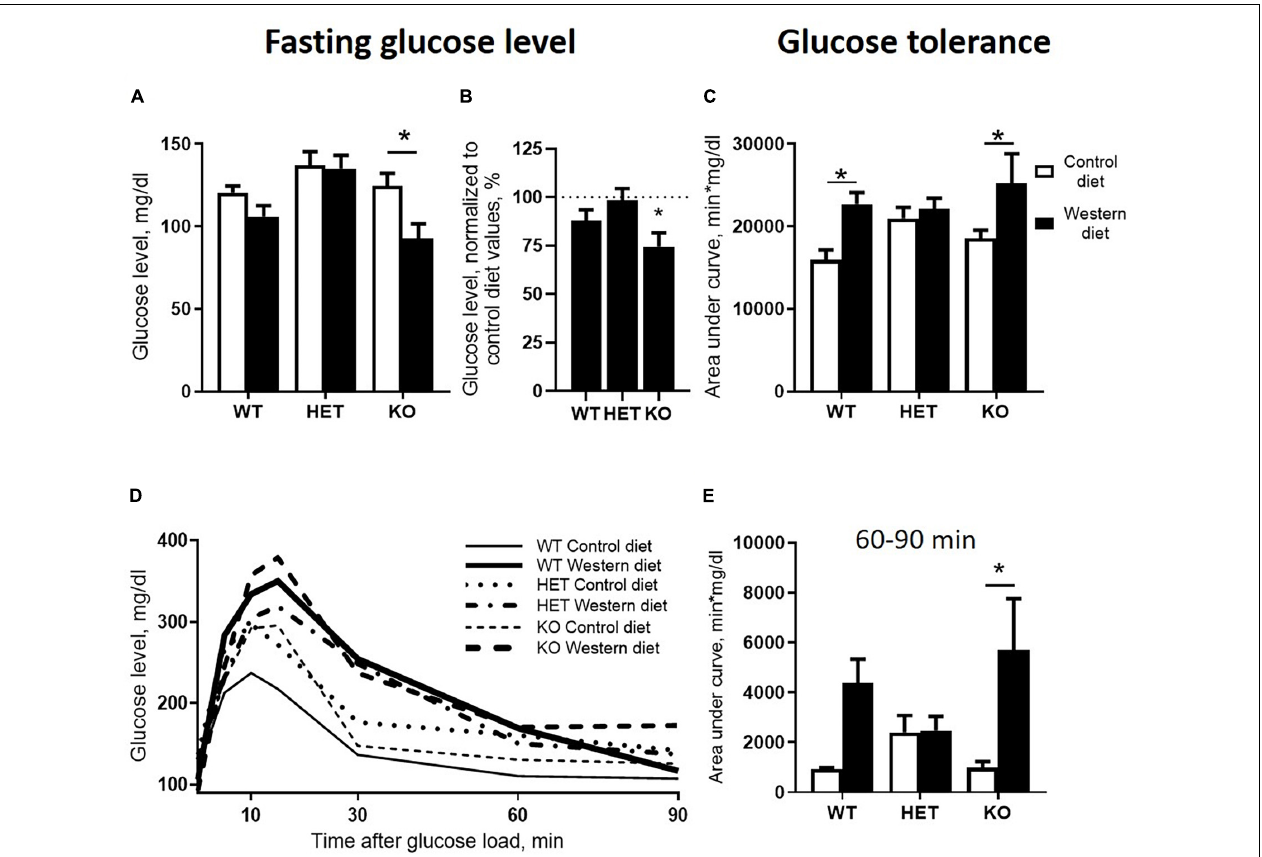
FIGURE 3 | Effects of Western diet feeding on glucose tolerance. (A) Fasting blood glucose level after 18 h of food deprivation. WD decreased fasting glucose level in KO mice. (B) WD group basal glucose levels normalized to respective genotype group fed with CD values in comparison with 100%. (C) Area under glucose tolerance curve. WD increased area under the curve (AUC)_ in WT and KO mice. (D) Glucose tolerance curve. (E) Area under glucose tolerance curve for the period between 60 and 90 min. * p < 0.05, two-way ANOVA and Tukey’s test (A,C,E) or one sample t test vs. 100% (B) , six to seven animals per group were used. Data are shown as mean ± SEM (A–C, E) or mean (D)